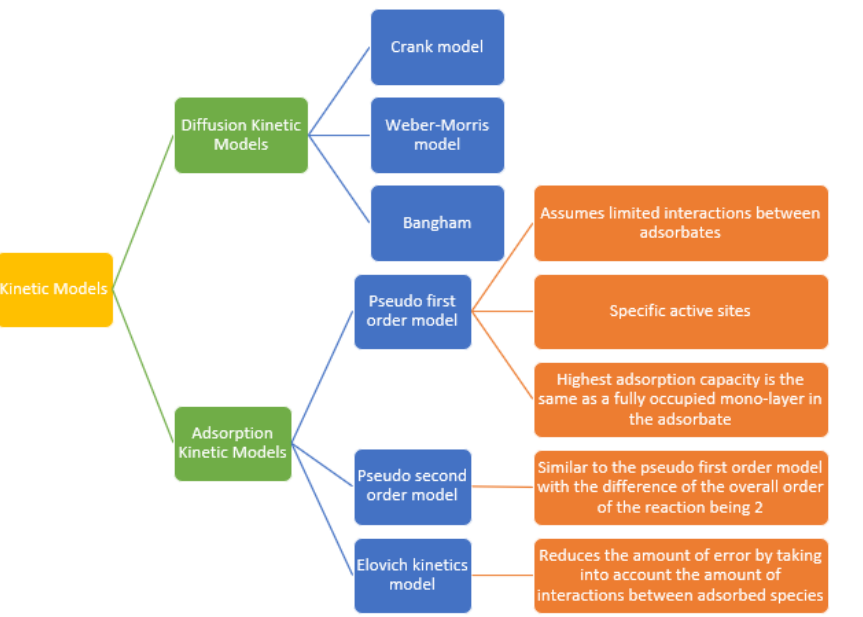
Figure 15. Diffusion kinetic models and adsorption kinetic models.